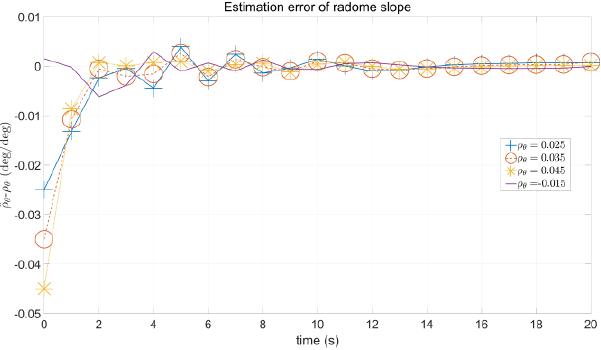
λ ME and the true LOS angular rate .